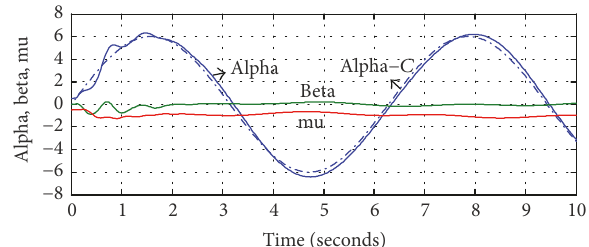
Figure 15: Compensated tracking results of AOA sinus.